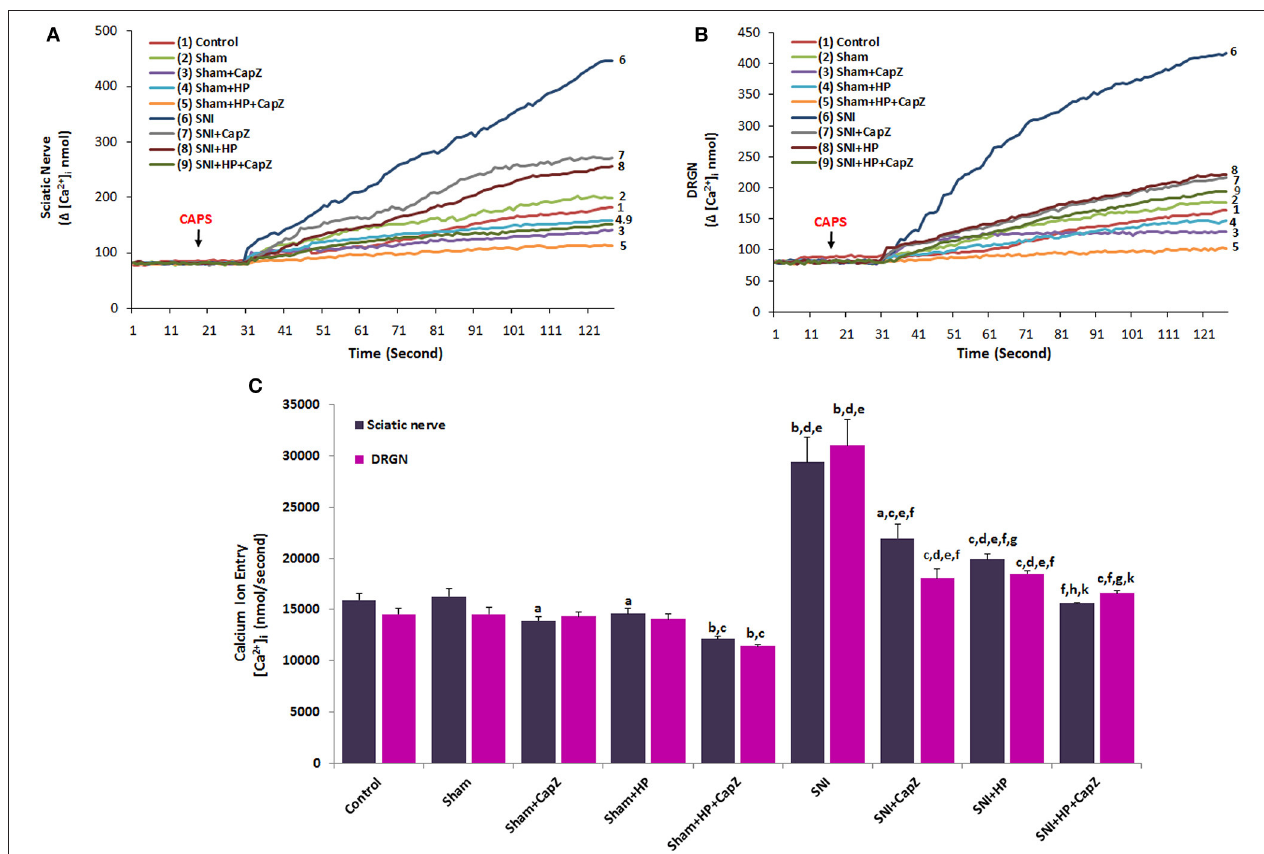
FIGURE 3 | Effect of Hypericum perforatum (HP) treatment on [Ca 2 + ] i concentration and TRPV1 in sciatic nerve (A) and dorsal root ganglion neuron (DRGN) (B) of control, sham and SNI-induced rats. ( n = 8 and mean ± SD). The animals received oral HP for 4 weeks. Then, these dissected neurons of control, sham and SNI were further in vitro treated with CAPS (0.01 mM) and CapZ (0.1 mM) before loading Fura-2 for 125s. a p ≤ 0.05 and b p ≤ 0.001 vs. control and sham groups. c p ≤ 0.05 and d p ≤ 0.001 vs. sham + CapZ and sham + HP groups. e p ≤ 0.001 vs. sham + HP + CapZ group. f p ≤ 0.001 vs. SNI group. g p ≤ 0.05 and h p